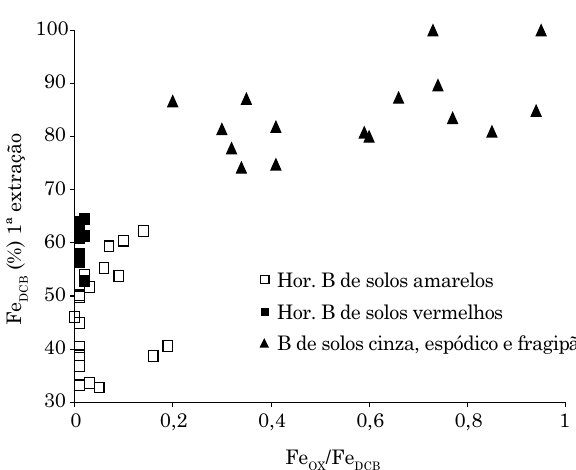
Figura 2. relação entre os teores de Fe 2 O 3 removidos na primeira extração por ditionito-citrato-bicarbonato (DCb) na terra fina seca ao ar e os valores da relação Fe OX /Fe DCb para horizontes b, horizontes espódicos e fragipã dos solos estudados.